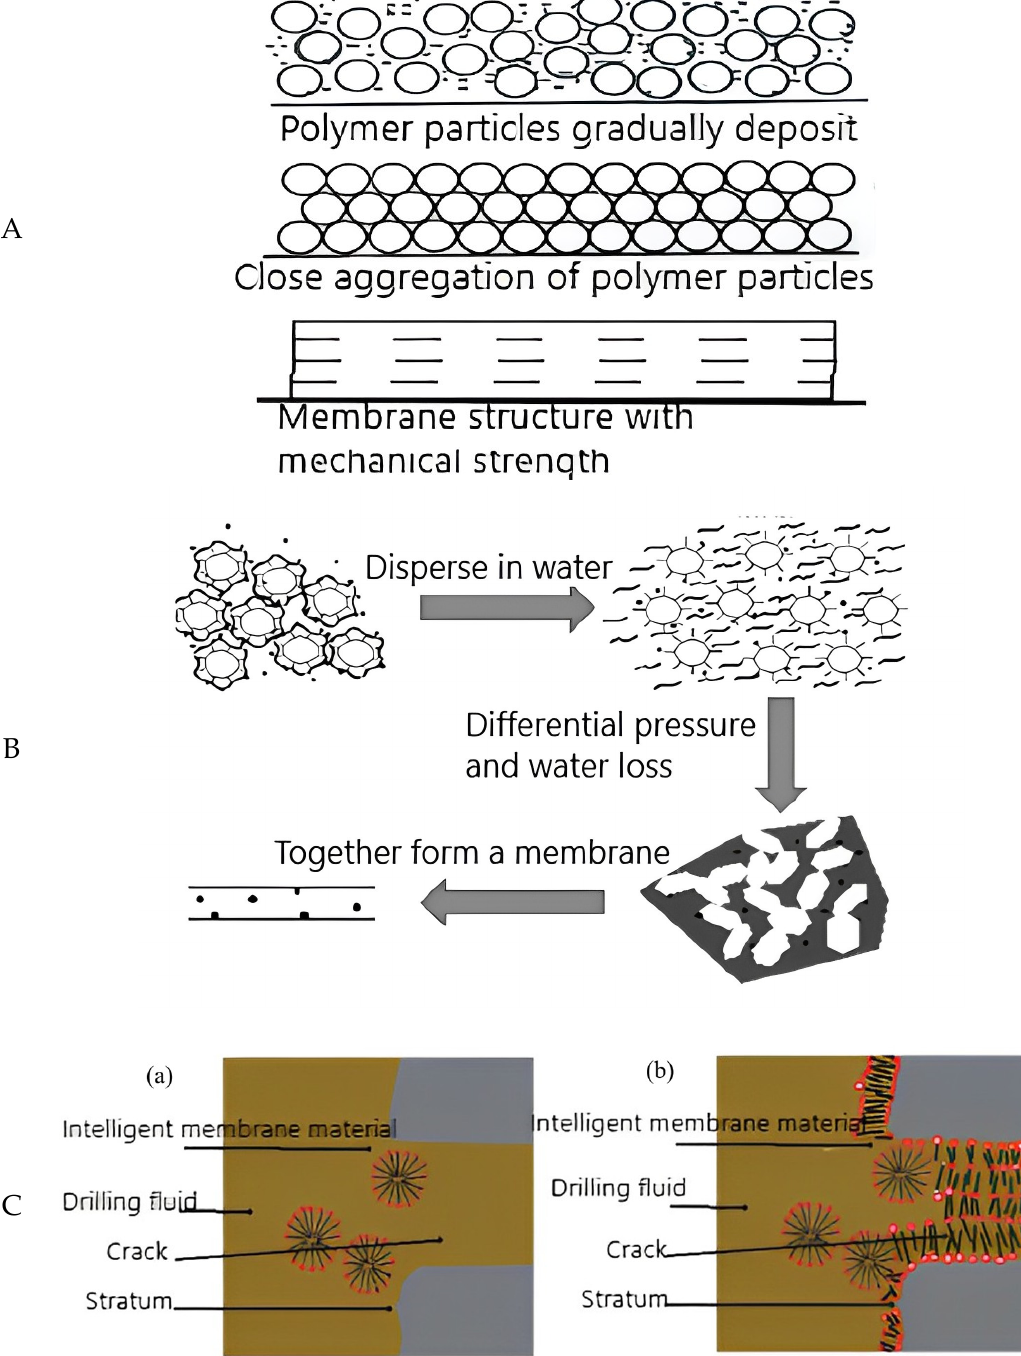
Figure 6. ( A ) Schematic diagram of polymer stacking into film [101]. ( B ) PF-HCM film formation process [102]. ( C ) Schematic diagram of intelligent membrane plugging principle. ( a ): Intelligent membrane material enters the leakage layer; ( b ): intelligent membrane material seals the leakage layer [38].